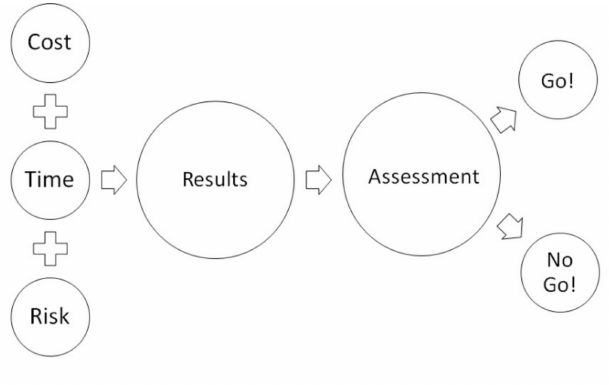
Figure 3. Flow chart of assessment plan for